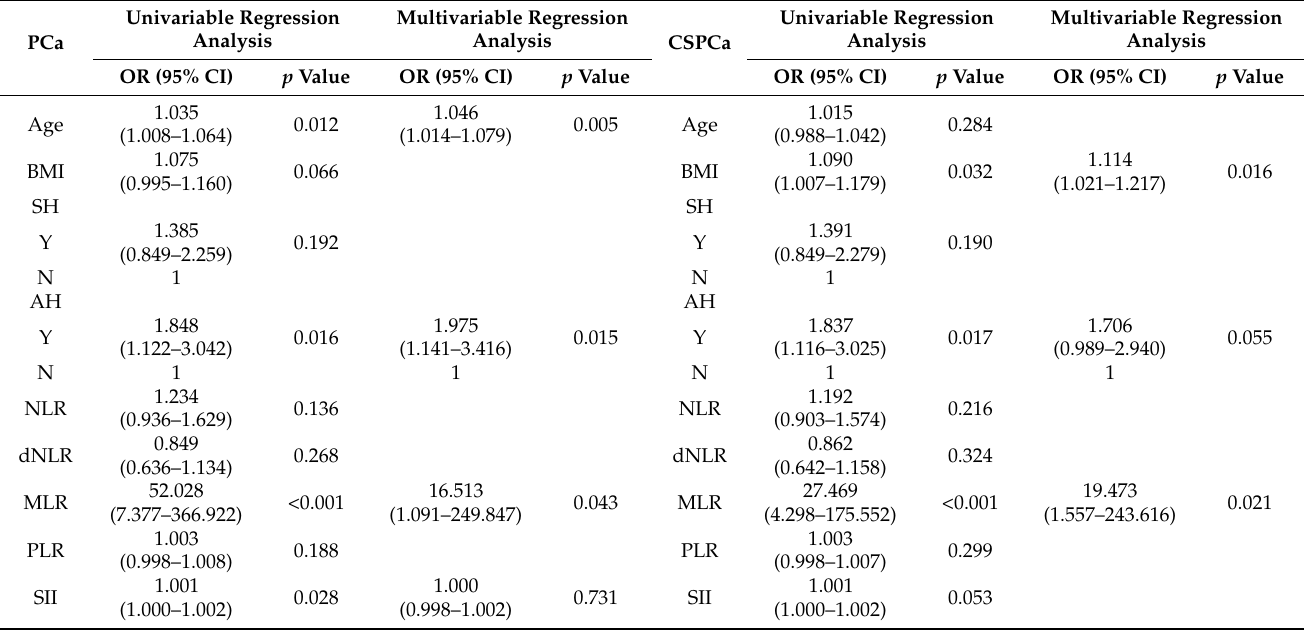
Table 2. Univariable and multivariable analyses of clinical